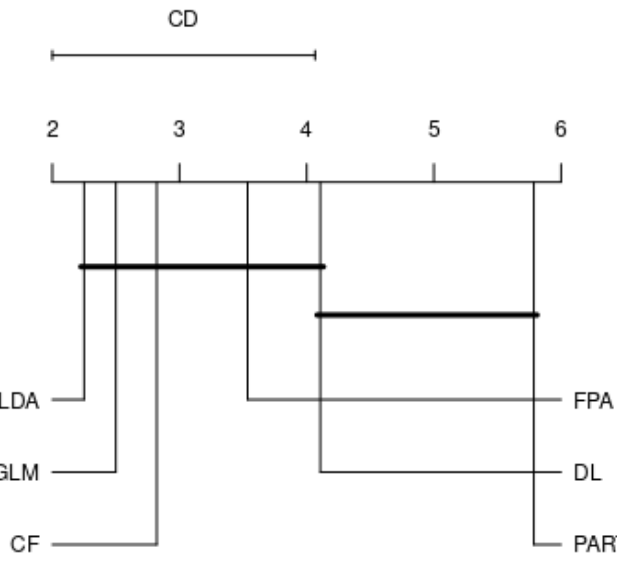
Figure 7. Critical difference plot of selected classifiers in terms of